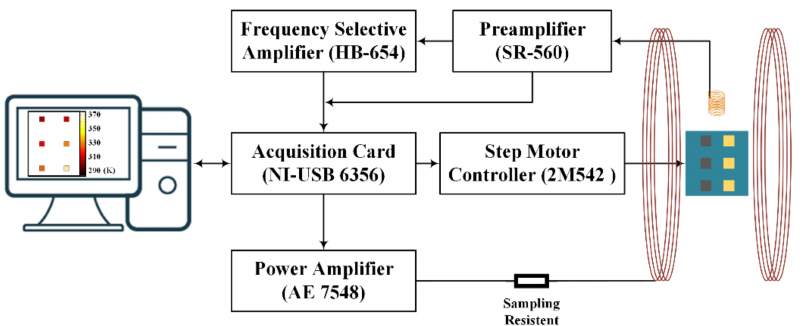
Figure 4. Sketch-view of the experimental setup used to measure the 2-D temperature distribution by scanning using a magnetic nanoparticles thermometer.